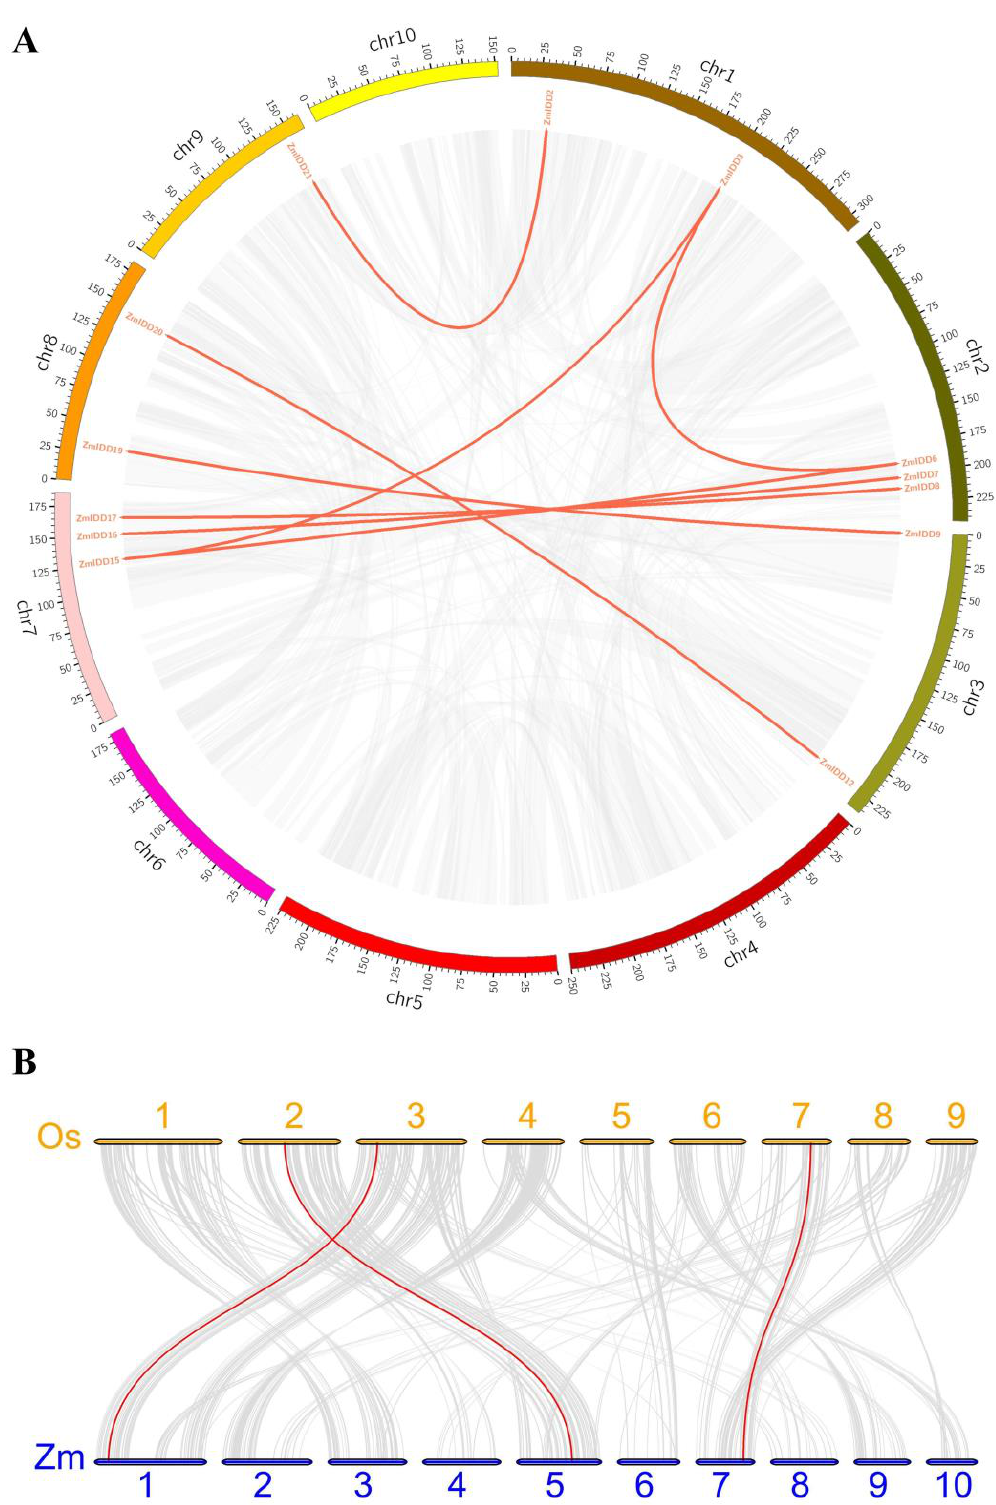
Figure 6. The synteny analysis of ZmIDD family genes. ( A ) The synteny analysis of the ZmIDD family in maize. Gray lines indicate all synteny blocks in the maize genome. The genes linked by red lines represent homologues. ( B ) Synteny analysis of IDD genes between maize and rice. Gray lines: all collinear blocks within maize and other plant genomes. Red lines: the synteny of IDD gene pairs. The species names with the prefixes Zm and Os indicate maize and rice, respectively.